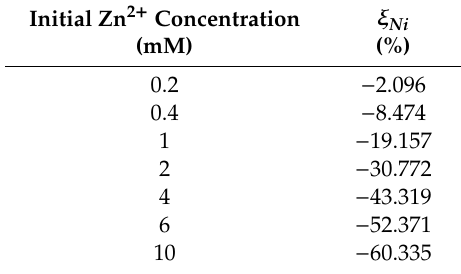
Table 1. The global index of behavior for Ni 2 + biosorption ( ξ Ni ) at di ff erent initial Zn 2 + concentrations.